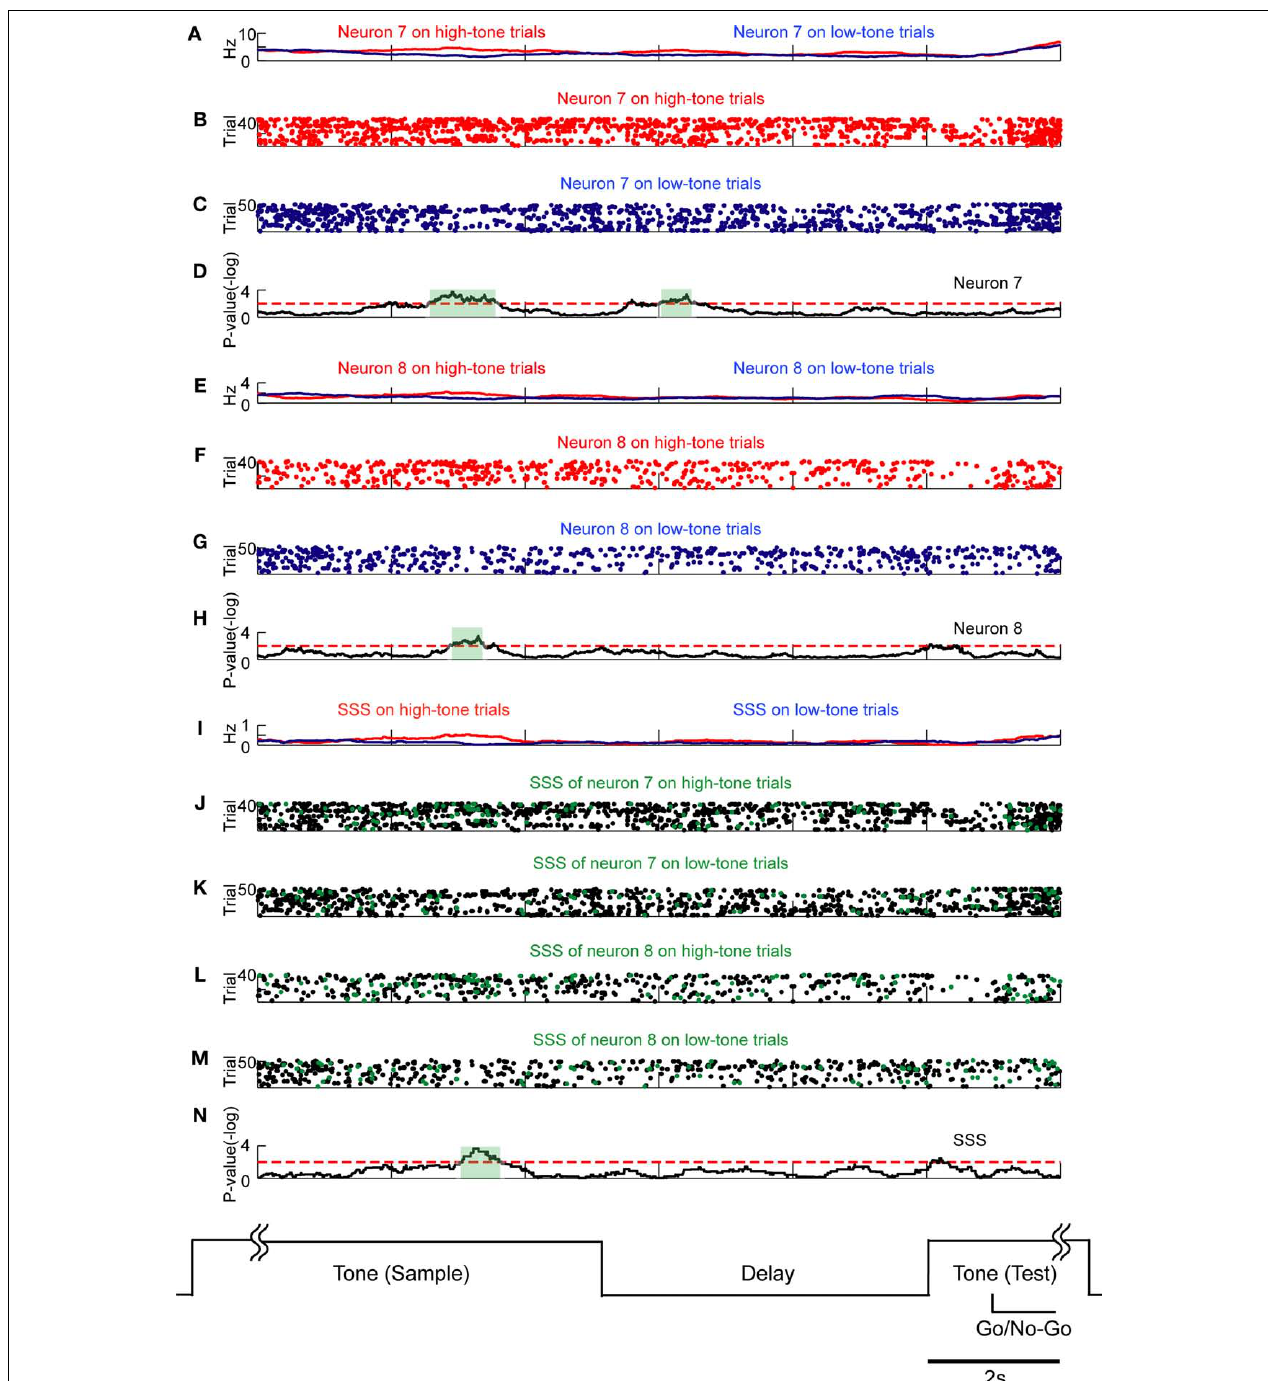
FIGURE 5 | SSSs related to stimulus inputs are associated with fi ring rate modulations. Comparison of SSSs and rate modulations between high tone and low tone trials was selected in this example. Each subfi gure averages all correct trials of a session. Results of U -tests of 5 s of tone presentation in the preceding trial, 5 s of delay, and 2 s of tone presentation in the next trial are shown. Additional details are described in Section ‘Materials and Methods’. (A) Firing rates of neuron 7 in high tone (red) and low tone (blue) trials. (B,C) Raster plots of spikes of neuron 7 in high tone (red) and low tone (blue) trials. (D) P -values of